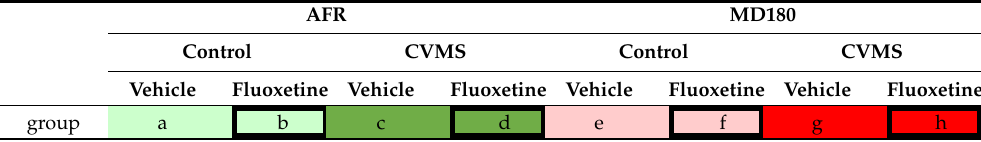
Table 1. Experimental design. Lettering (a–h) and the background color of cells in the “group” row correspond to the labeling of bars in Figures 1–4. Green: animal-facility-reared (AFR) groups; red: groups with history of maternal deprivation (MD180). Control (light shade) and chronic variable mild stress (CVMS)-exposed (dark shade) groups were subdivided into vehicle- and fluoxetine-treated subgroups (thick black